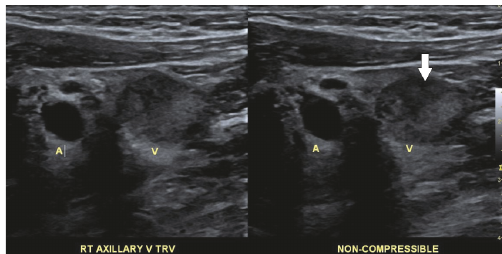
Figure 2: Doppler ultrasound showing noncompressibility of the axillary vein (arrow) due to thrombus.